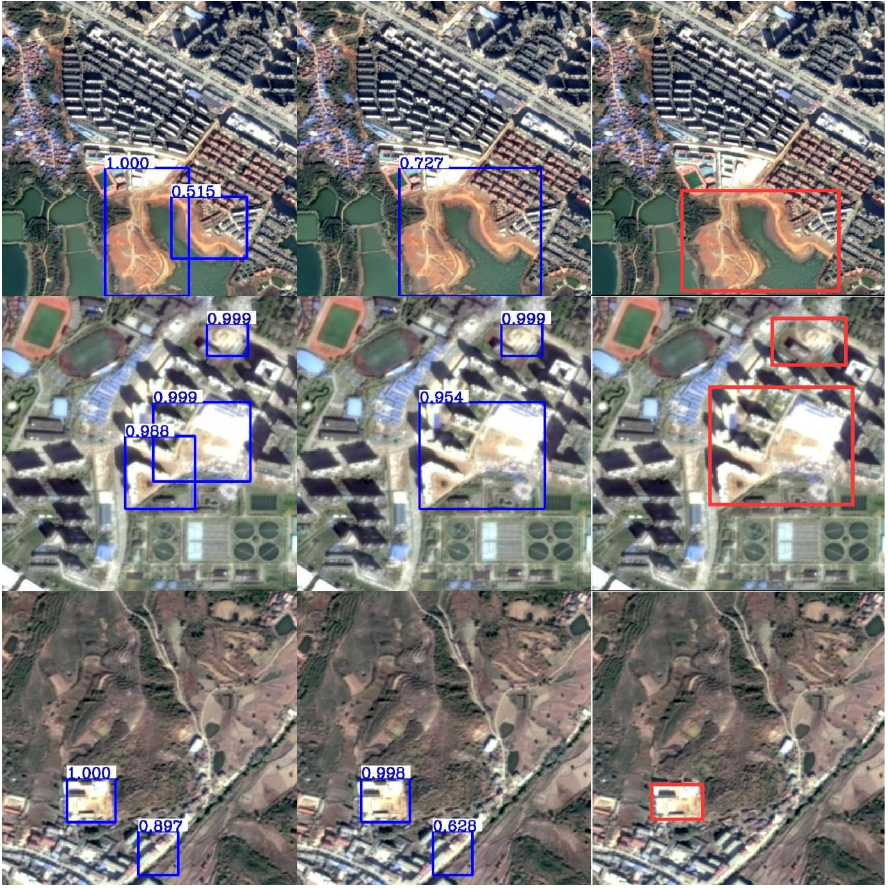
Figure 7. Detection results of the Faster RCNN method and this method. Each row in the figure is from the same image as a group for detection. From left to right, the purple candidate boxes in the first and second columns are detection results of Faster RCNN and this method respectively, and the red boxes in the third column are ground truth